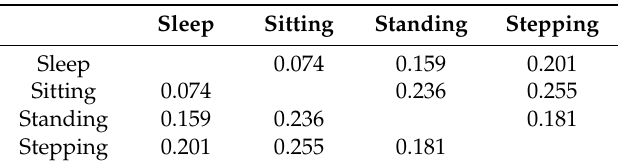
Table 3. Variation